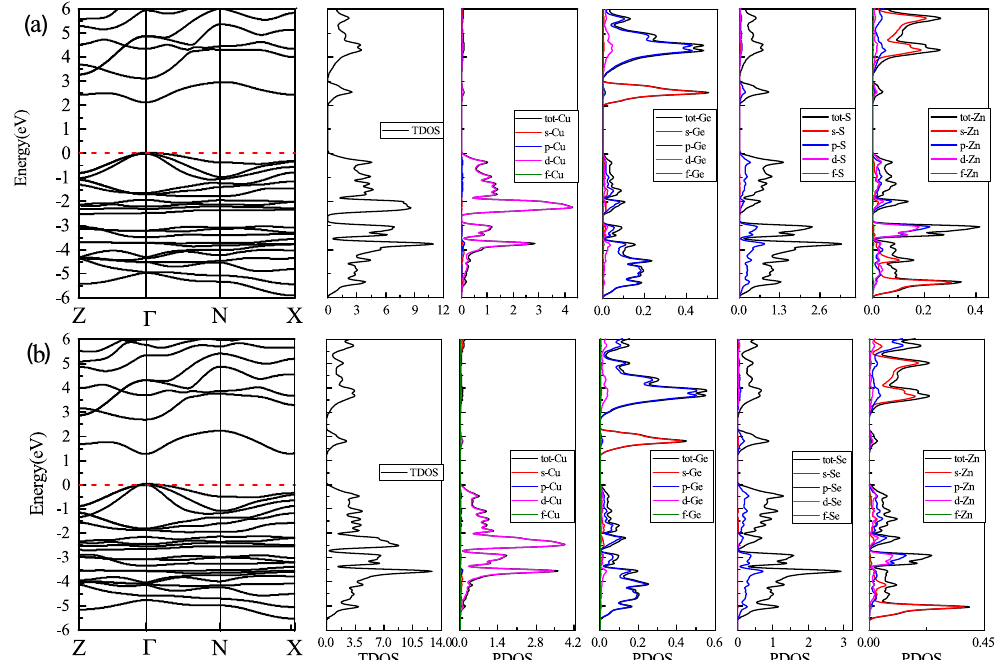
Figure 3. Schematic band structure, total and partial density of state mapped out from DFT/GGA calculations using the mBJ + U potential: ( a ) for CZGS and ( b ) for CZGSe. The dashed line refers to the Fermi level.